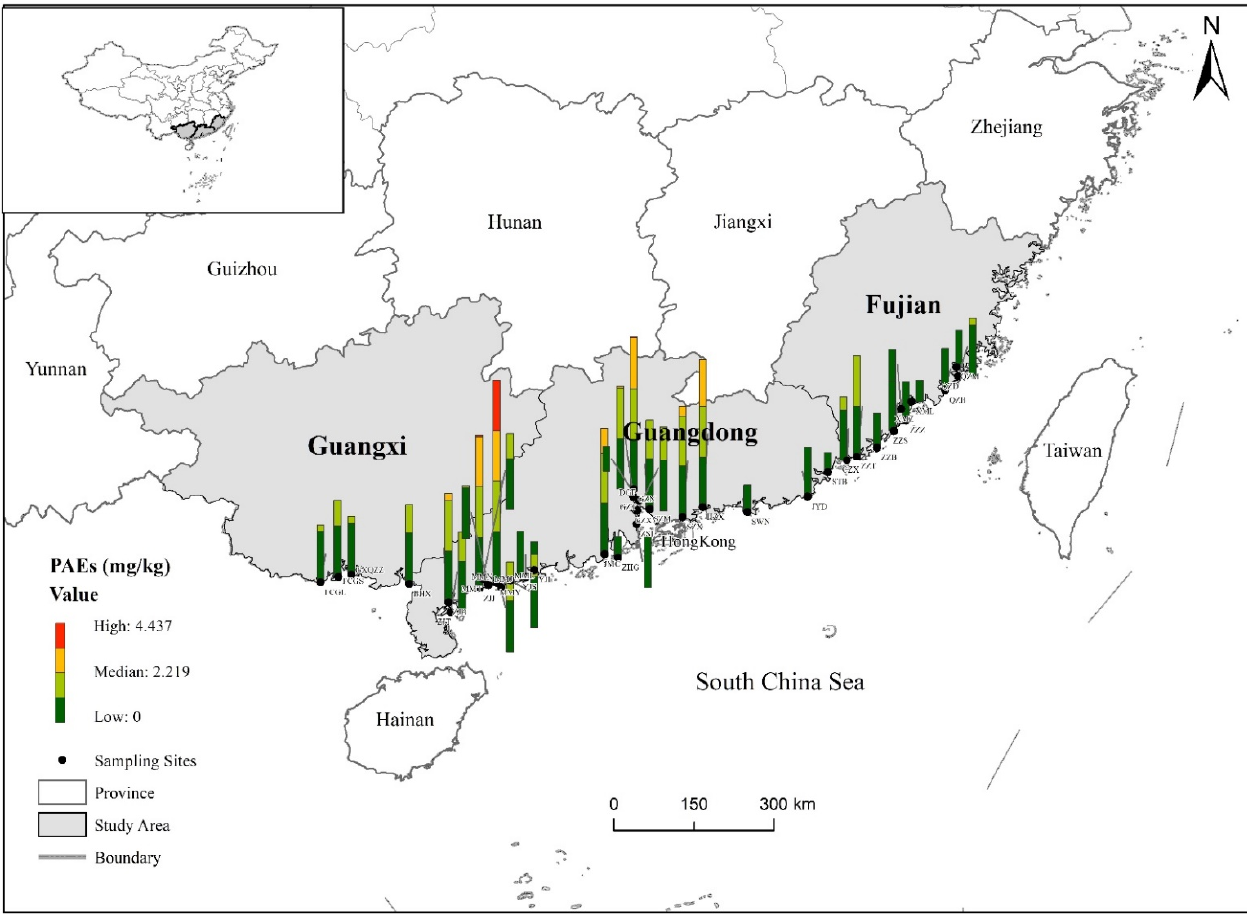
Figure 1. Concentration and geographical distribution of PAEs in agricultural soil in coastal areas of South China.